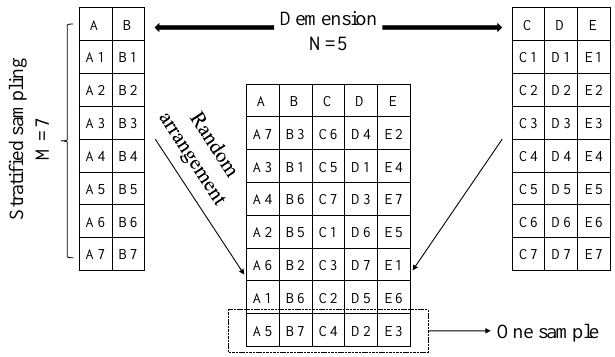
Figure A2. Latin hypercube sampling principle.